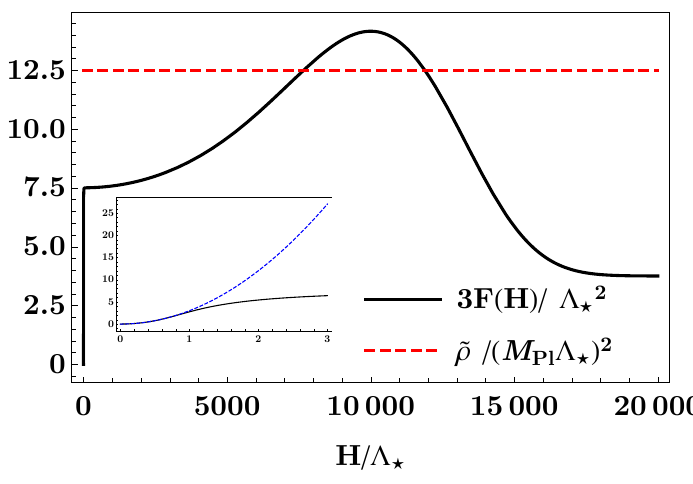
Figure 3 . Initial set up in the Gaussian model with parameters c σ = 0 . 7 , Γ = 10 8 , m = 500 Λ ? , and an initial value ˜ φ = 0 . 01 M Pl . Inset: Zooming in showing that F ( H ) approaches the GR value — blue dashed line — , H 2 , as H → 0 .